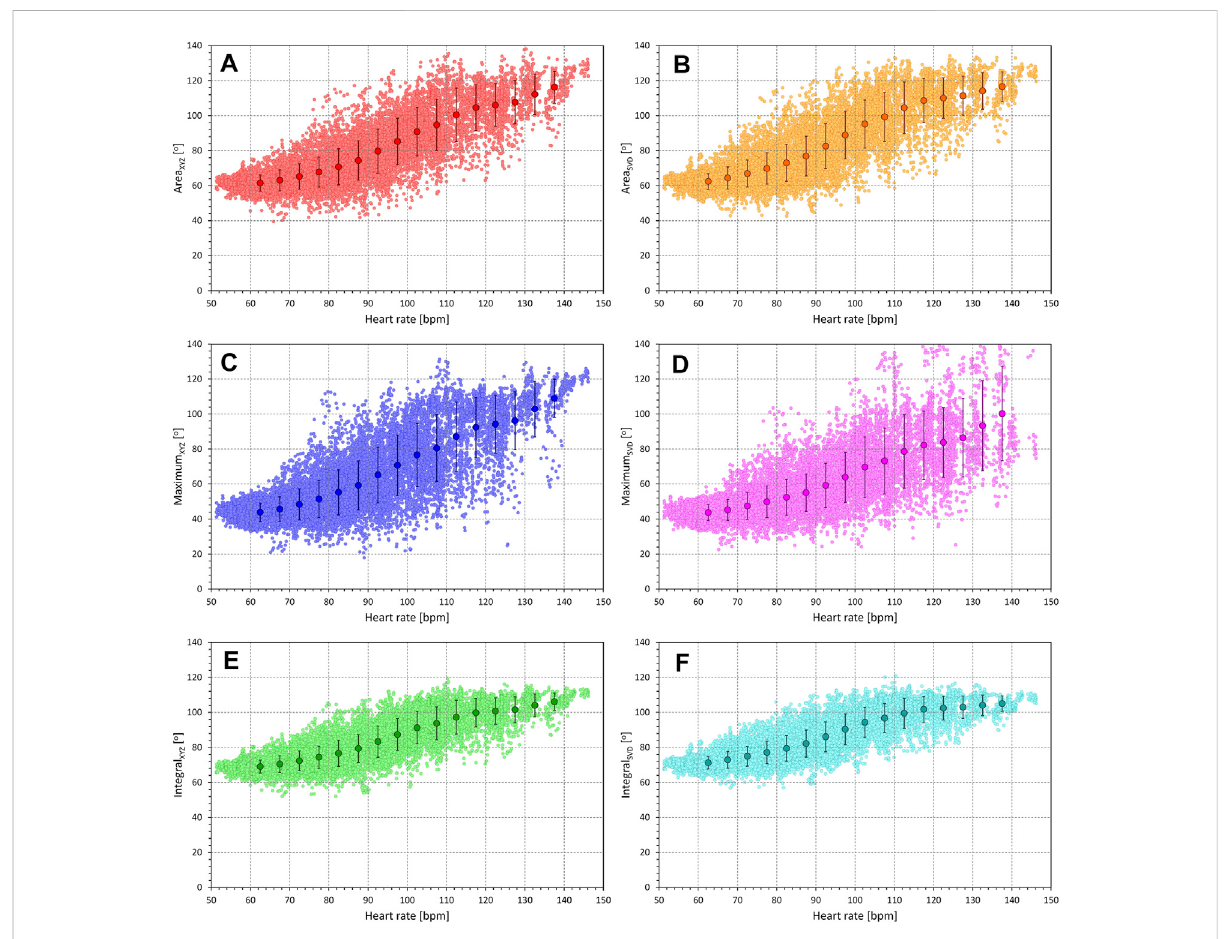
FIGURE 7 Example of the relationship of beat-based measurements of QRS-T angle and the heart rate measured over 1 min preceding each angle measurements. The data were obtained from the recordings of a 24.4-year-old male subject. The layout of the fi gure and the meaning of the symbols correspond to those in Figure